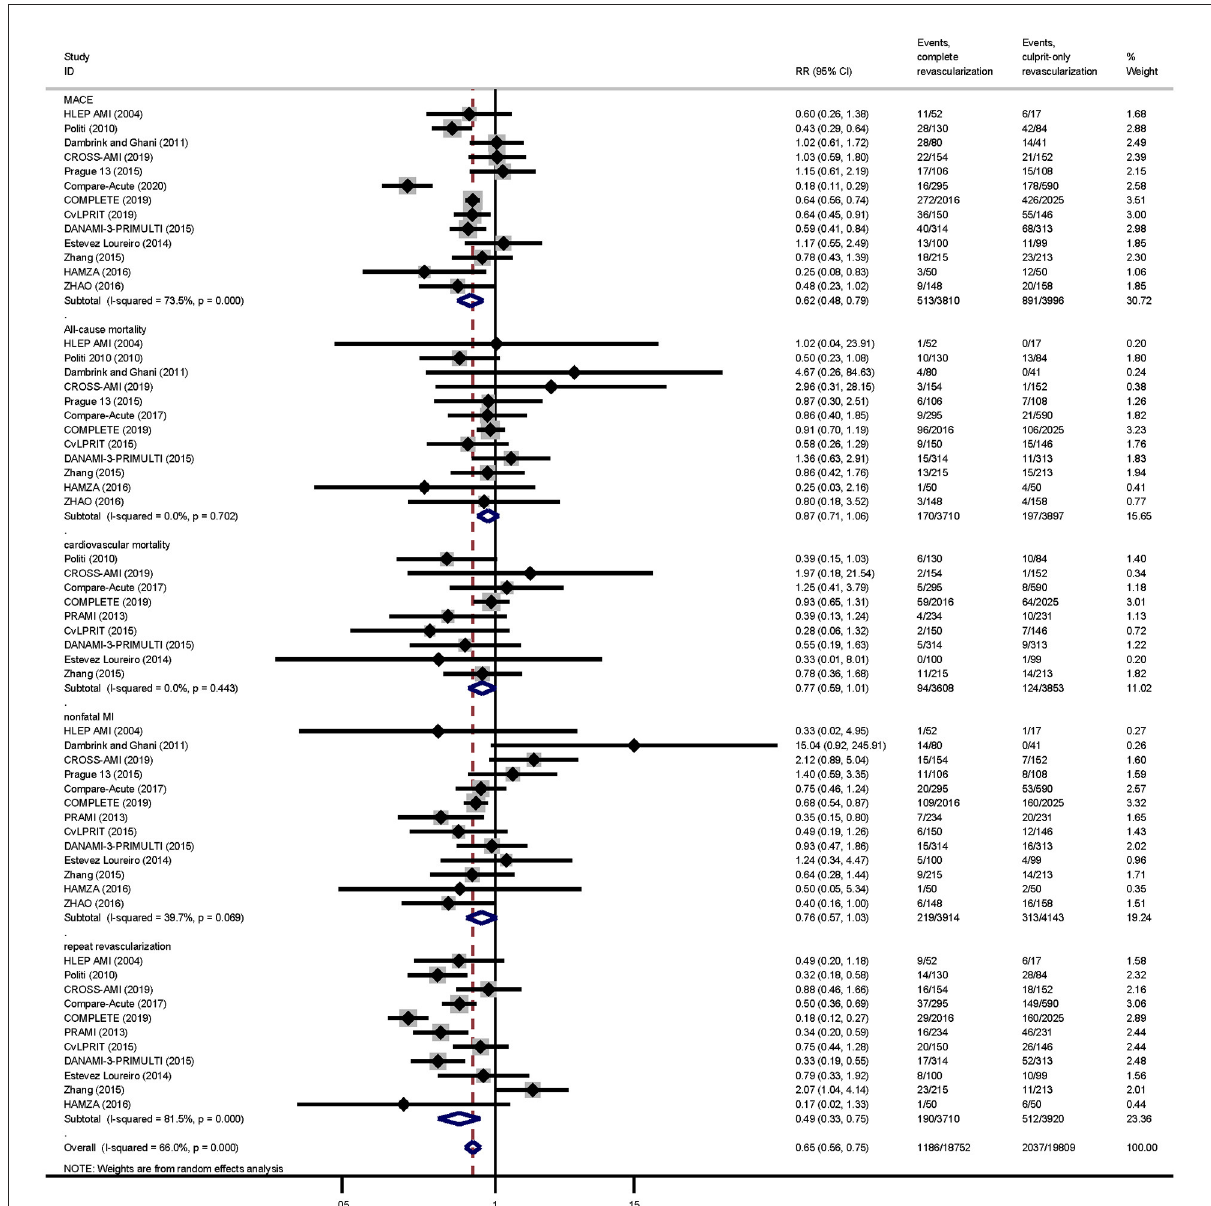
FIGURE3 Pairwise meta-analysis main outcomes. Summary forest plot for major adverse cardiac events, cardiovascular mortality, all-cause mortality, repeat revascularization, and nonfatal myocardial infarction in the pairwise meta-analysis. CI, confidence interval; MACE, major adverse cardiac event(s); RR, risk ratio; MI, myocardial infarction; Other abbreviations as in Table 1.